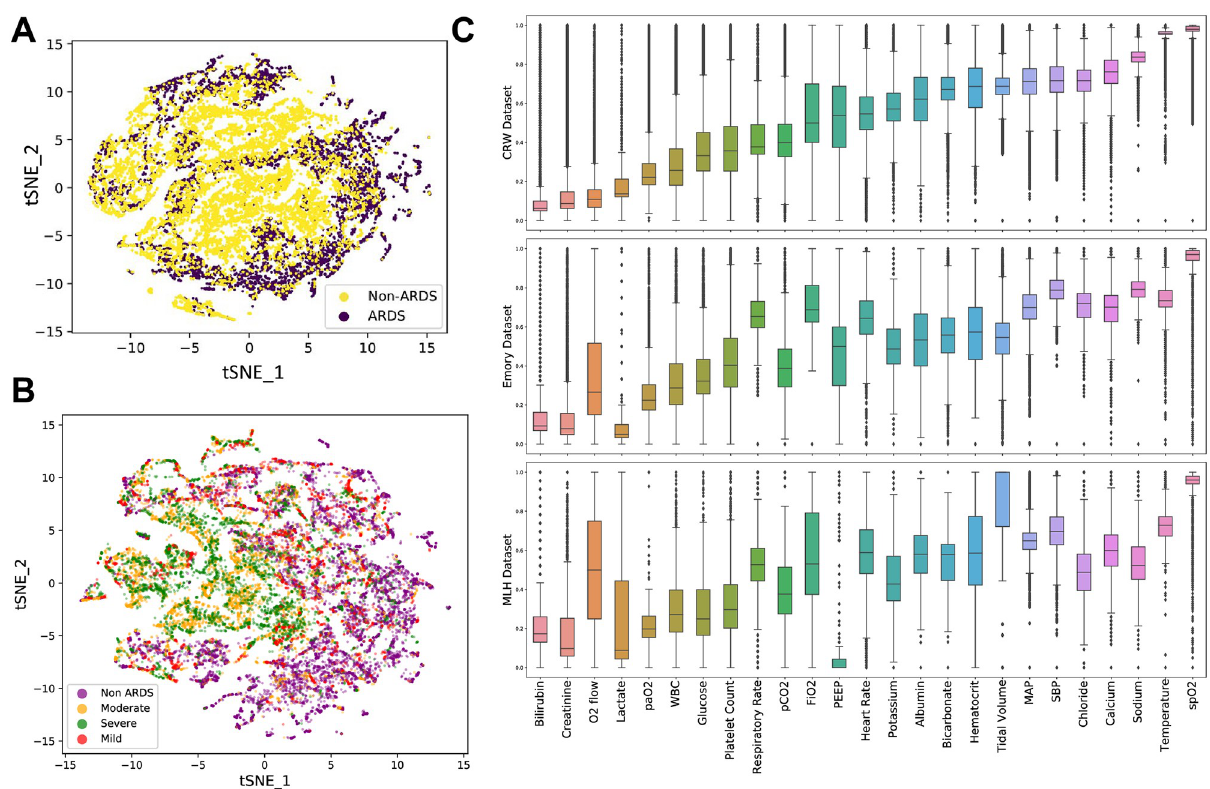
Fig 1. Characteristic analysis of the data. A. Illustrates a t-SNE plot of ARDS vs non-ARDS comparing across all predictors, two localised clusters emerge consisting of ARDS (yellow) patients; B. t-SNE plot of ARDS Severity, classified as mild, moderate and severe, significant convergence can be observed among the moderate and severe groups with non-ARDS and mild groups similarly forming a separate cluster. C. A box-plot of data density is illustrated, with each of the variables compared across the three data sources. Statistical significance is observed in all variables except PaO 2 and